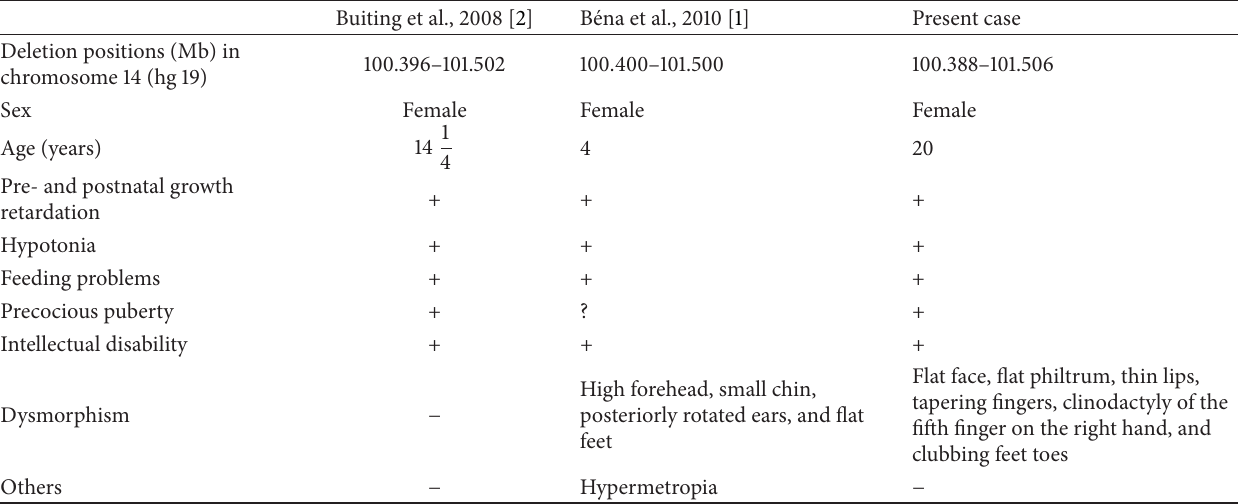
Table 1: Genomic coordinates and clinical features of all